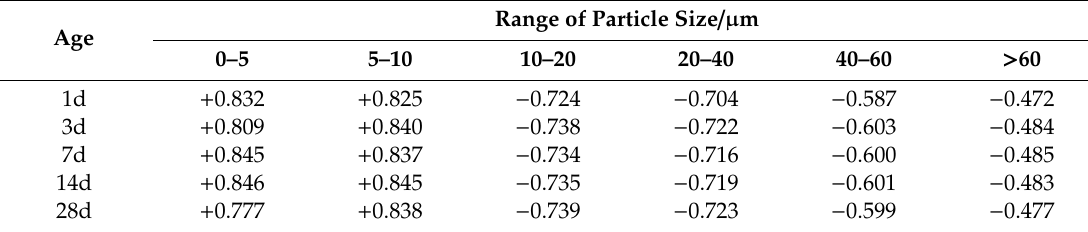
Table 7. Gray correlation